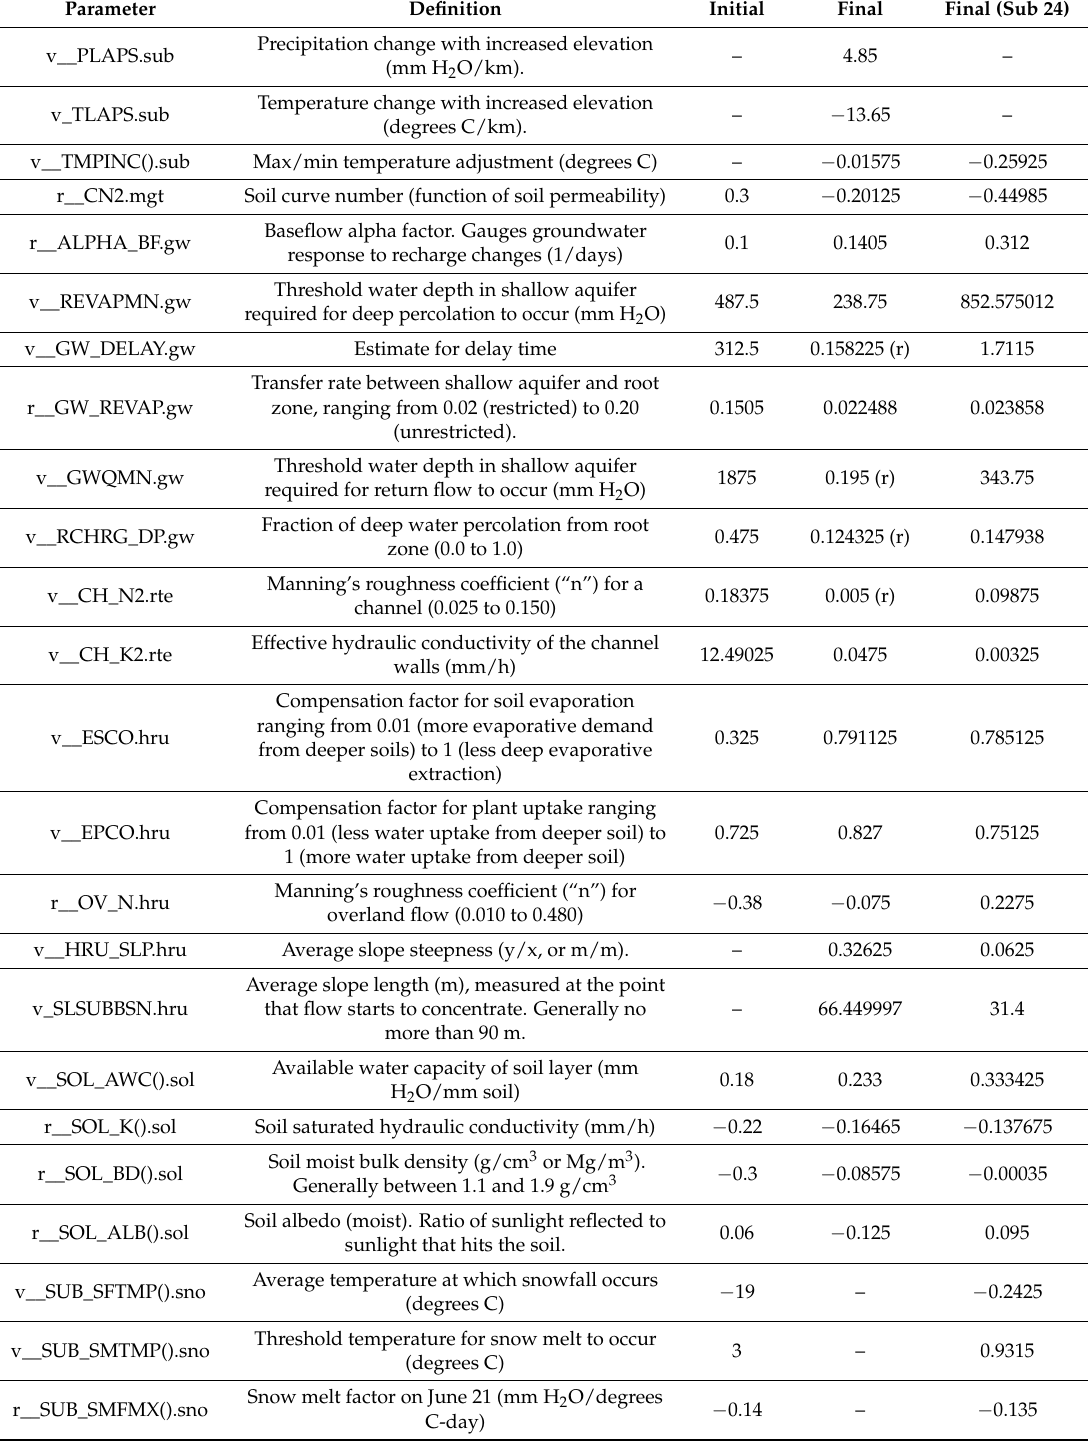
Table A4. List of definitions for all parameters used in the SWAT-CUP calibration process (definitions based on Abbaspour [35]). “sno” parameters are only applied to sub-basin 24. All other parameters were repeated with unique values for sub-basin 24. “v” denotes exact value changes, whereas “r” denotes relative changes (by a percentage) to the parameter value of interest. The “–” in some cells indicates that no value was